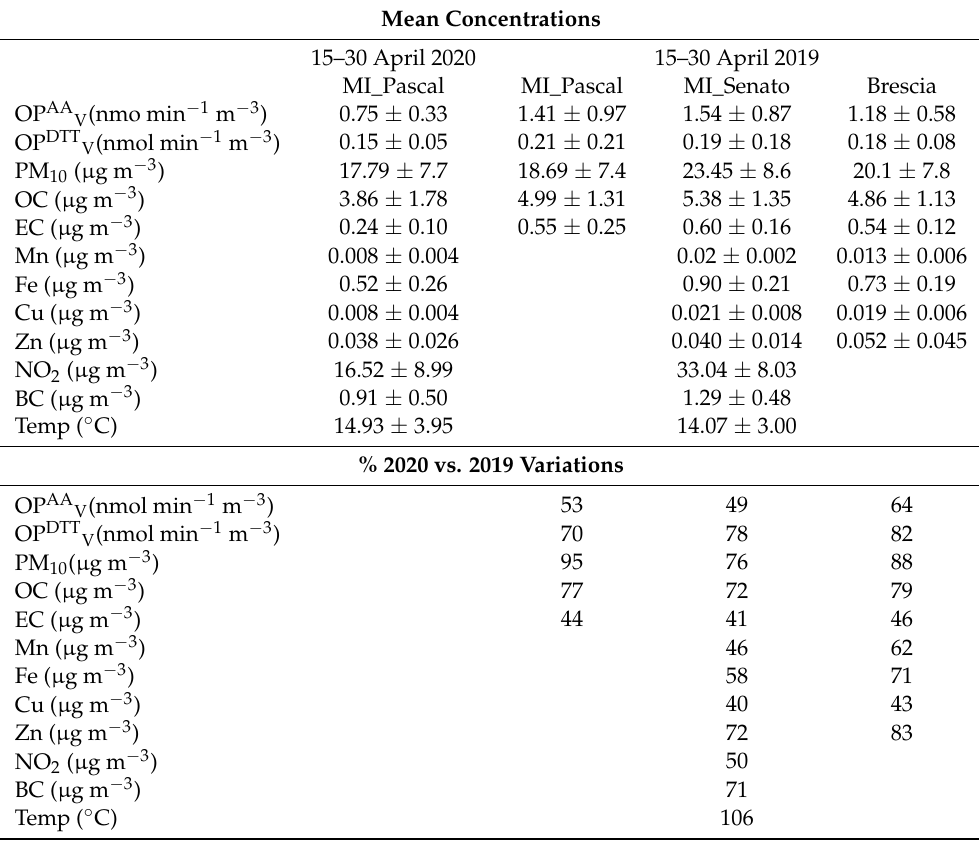
Table 4. Impact of the full lockdown restrictions on OP responses measured with AA and DTT assays and concentrations of PM 10 mass and its chemical components: mean values ( ± standard deviation) of the data obtained during the equivalent time span in 2019; % variation of each value at the MI_Pascal site in 2020 computed in comparison with data at MI_Pascal, MI_Senato and Brescia in 2019. Units: OP V (nmol min − 1 m − 3